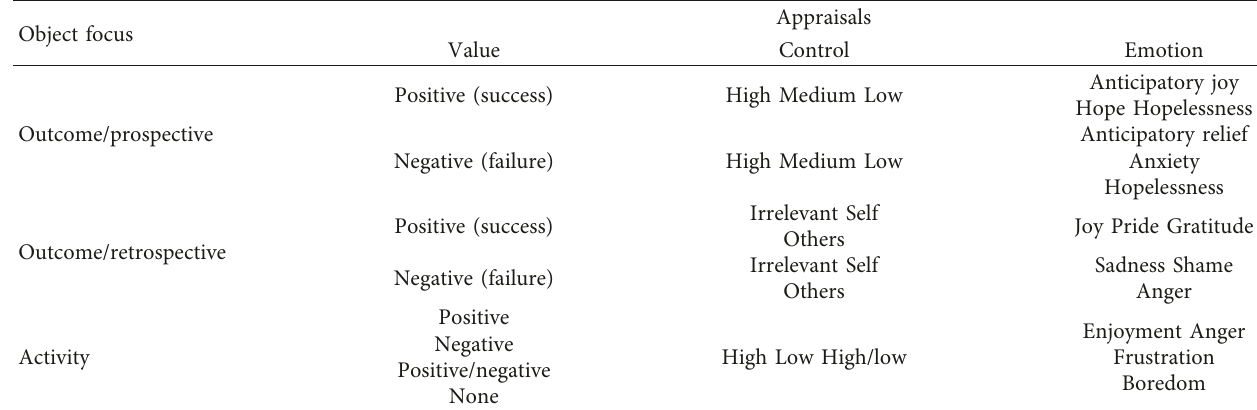
Table 1: The Control-Value Theory model (from